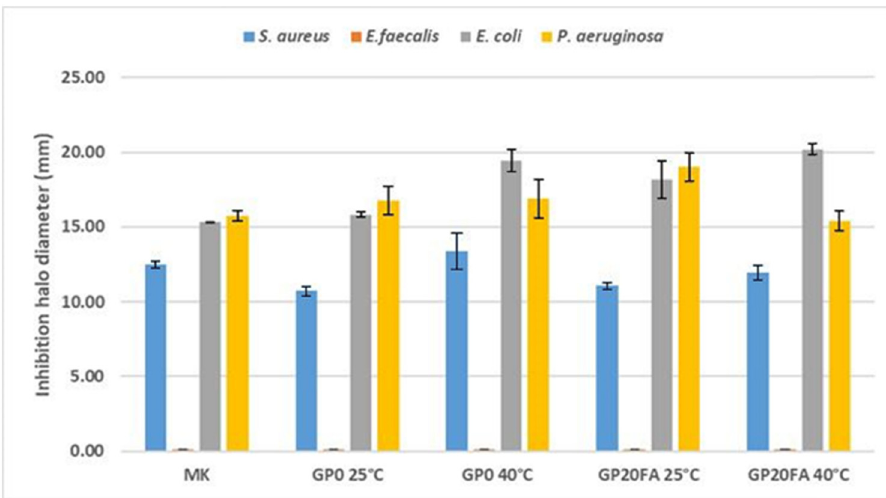
Figure 9: Inhibition halo diameter for the investigated composites.